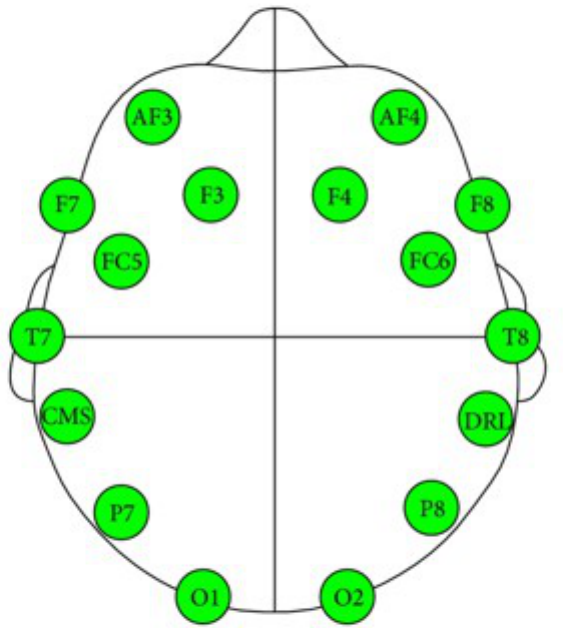
Figure 2. Emotiv EEG neuroheadset sensor position